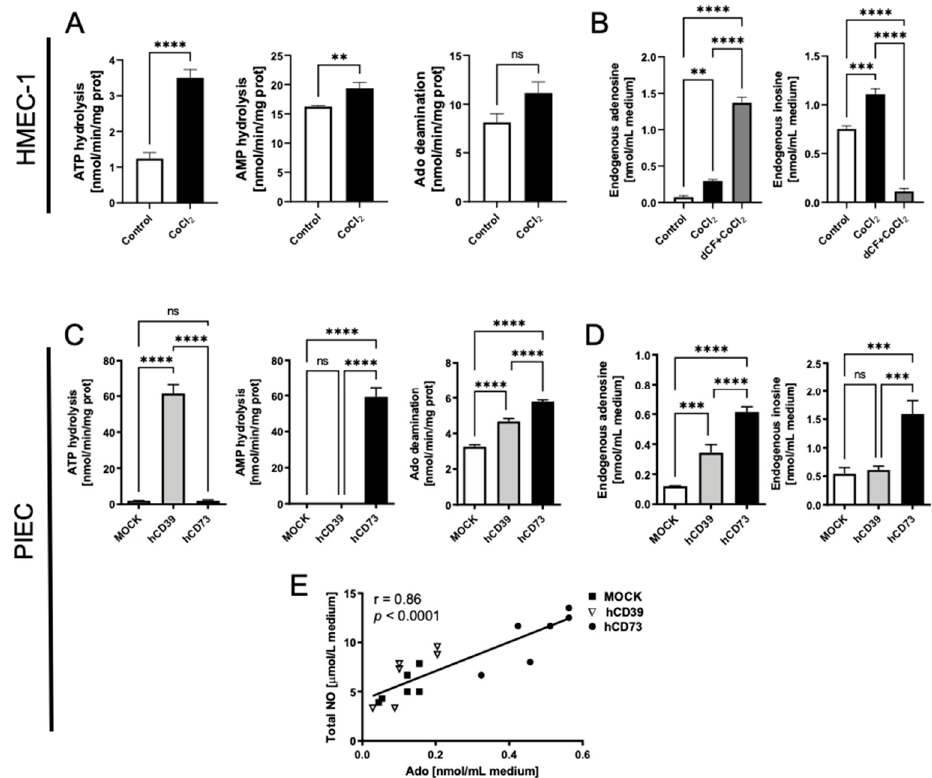
Figure 5. CoCl 2 -mimicked hypoxia upregulated extracellular nucleotide hydrolysis and adenosine deamination in human endothelial cells, while the inhibition of adenosine catabolism maintained its extracellular levels at those corresponded with enhanced NO release, as verified using porcine cells transfected with human ecto-nucleotidases. ( A ). The rates of extracellular ATP hydrolysis, AMP hydrolysis, and adenosine (Ado) deamination in control and CoCl 2 -treated cells. ( B ). Endogenous Ado and inosine (Ino) concentration in the medium of control and CoCl 2 -treated cells in the presence of absence of adenosine deaminase inhibitor, 2 ′ deoxycoformycin (dCF, 10 μ M). ( C ). The rates of extracellular ATP hydrolysis, AMP hydrolysis, and Ado deamination in mock-transfected porcine endothelial cells (MOCK-PIEC) and PIEC transfected with human CD39 (hCD39-PIEC) and CD73 (hCD73-PIEC). ( D ). Endogenous Ado and Ino concentration in the medium of MOCK-PIEC, hCD39-PIEC and hCD73-PIEC. ( E ). Pearson’s correlation of total nitric oxide (NO) vs. Ado concentration in the medium of MOCK-PIEC, hCD39-PIEC and hCD73-PIEC. Results are shown as mean ± SEM; n = 6; ** p < 0.01, *** p < 0.001, **** p < 0.0001; ns = not significant.